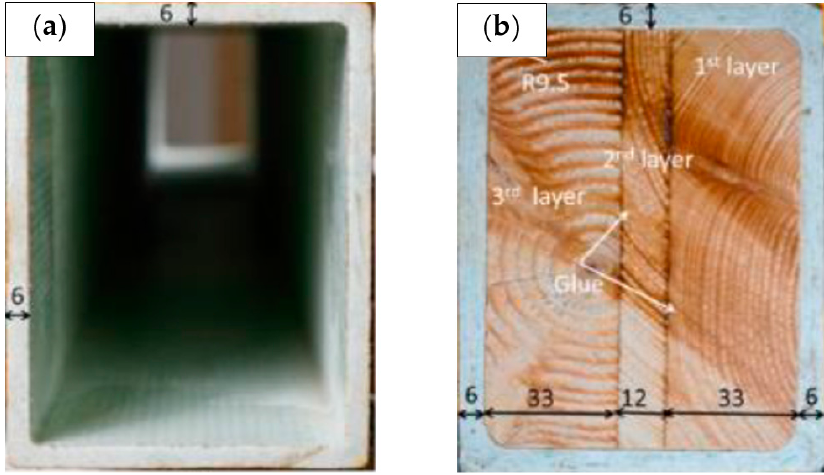
Figure 15. Specimens geometry and shaped for ( a ) hollow section and ( b ) sandwich section of pultruded GFRP beams [112].